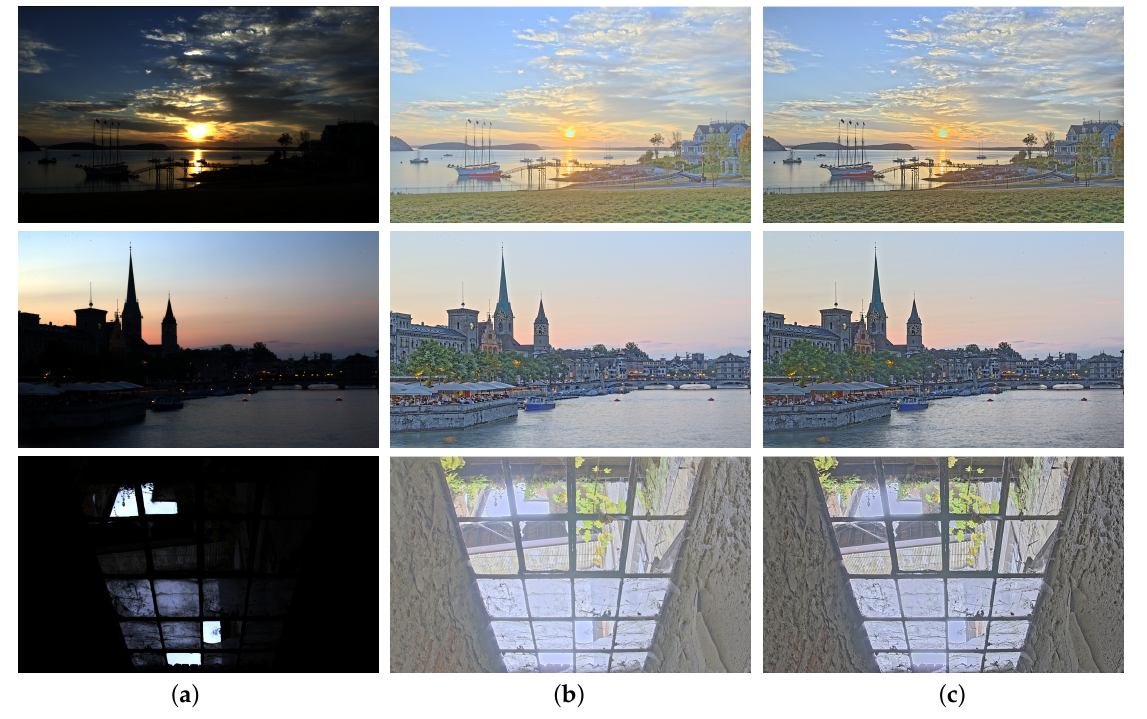
Figure 8. Comparison of the results of the luminance-domain TM algorithm in different preprocessing methods: ( a ) radiance map; ( b ) Gu [28]; ( c )